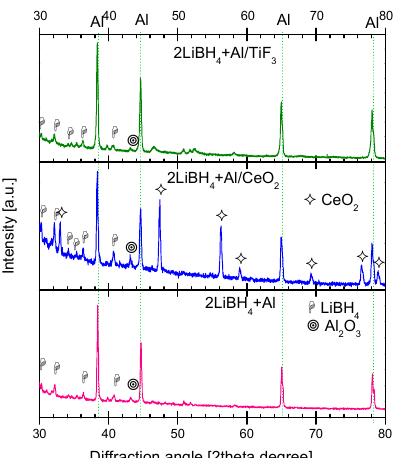
Figure 2. X-ray diffraction patterns of the as-milled materials: ( a ) 2LiBH 4 + Al; ( b ) 2LiBH 4 + Al/TiF 3 ; ( c ) 2LiBH 4 + Al/CeO 2 .